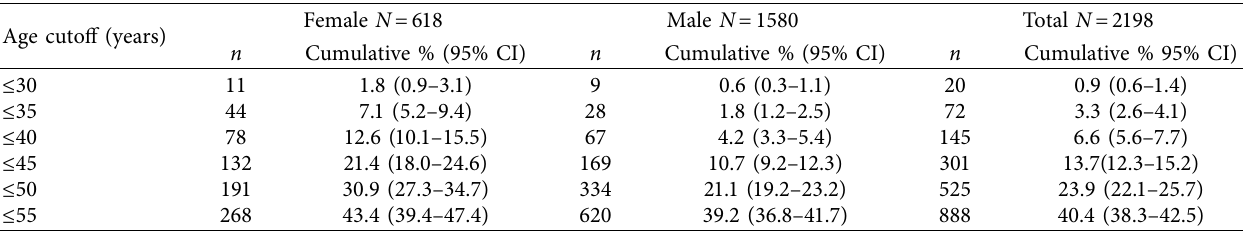
Minimum — < 40 ( n , %) Age range ≥ 40 ( n , %) Female ( n , %) Sex Male ( n , %) 249 (72.0) IQR: interquartile range. Table 3: Age cutoff of esophagogastroduodenoscopy according to the cumulative percentage of missed upper gastrointestinal malignancy. Female N � 618 Male N � 1580 Age cutoff (years)